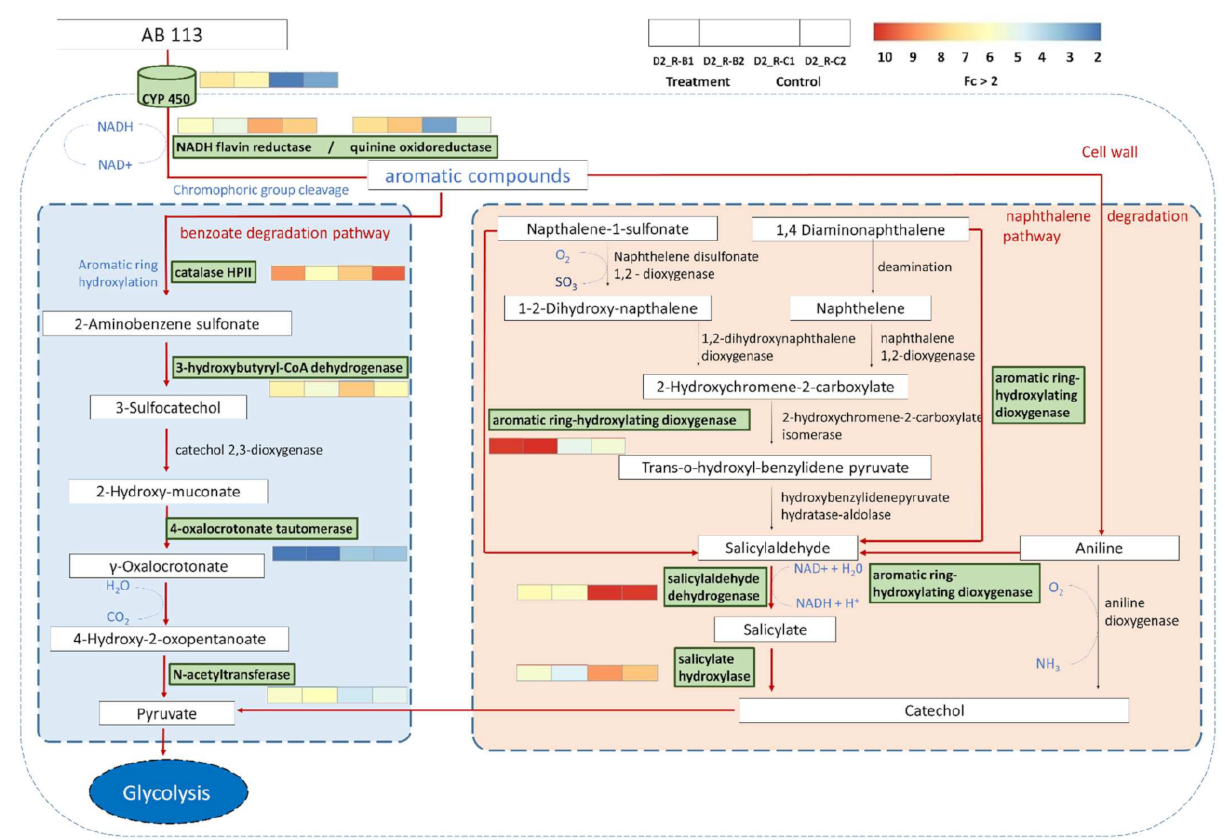
Figure 6. S. melonis B-2 DEG transcriptional changes in the AB113 degradation pathway. The enzymes present in the samples were represented in green boxes, whereas the other enzymes are mentioned for reference. The enzyme reactions and the arrows in red color marked between the metabolites represent the directions of catalytic reactions. The expression patterns of control and treatment with fc > 2 values in each enzyme are shown in a heat